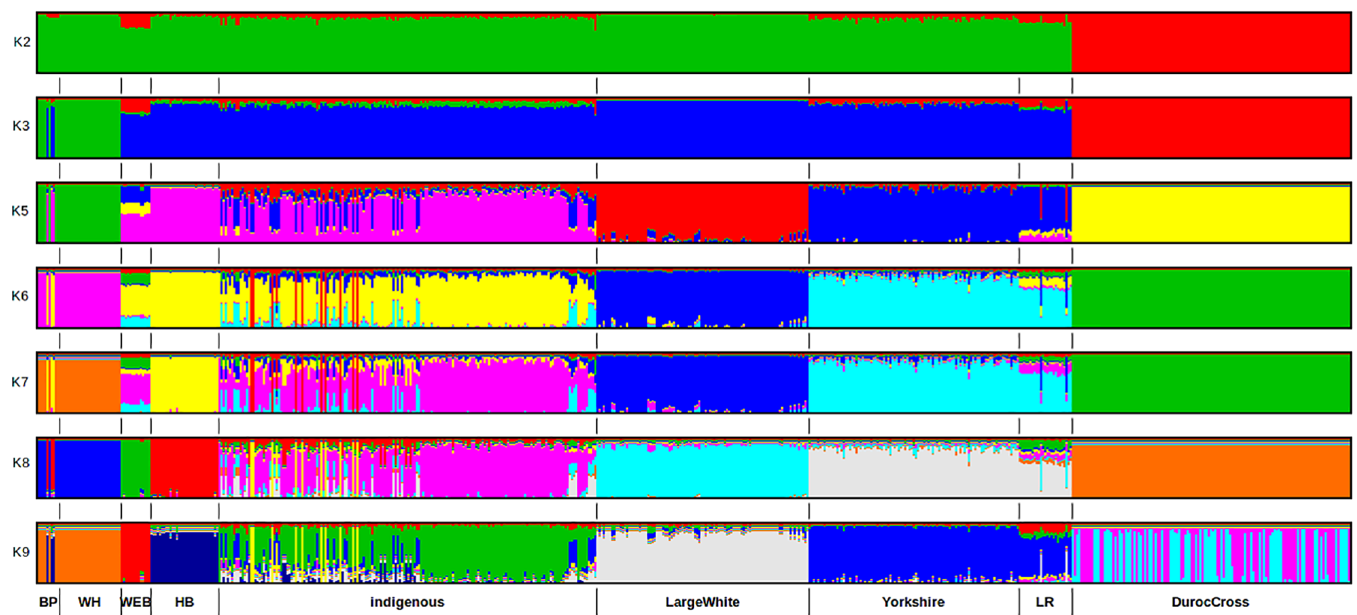
Fig 3. Admixture plot representing estimated membership coefficients for individual pigs for ancestral populations (K) ranging between 2 to 9.